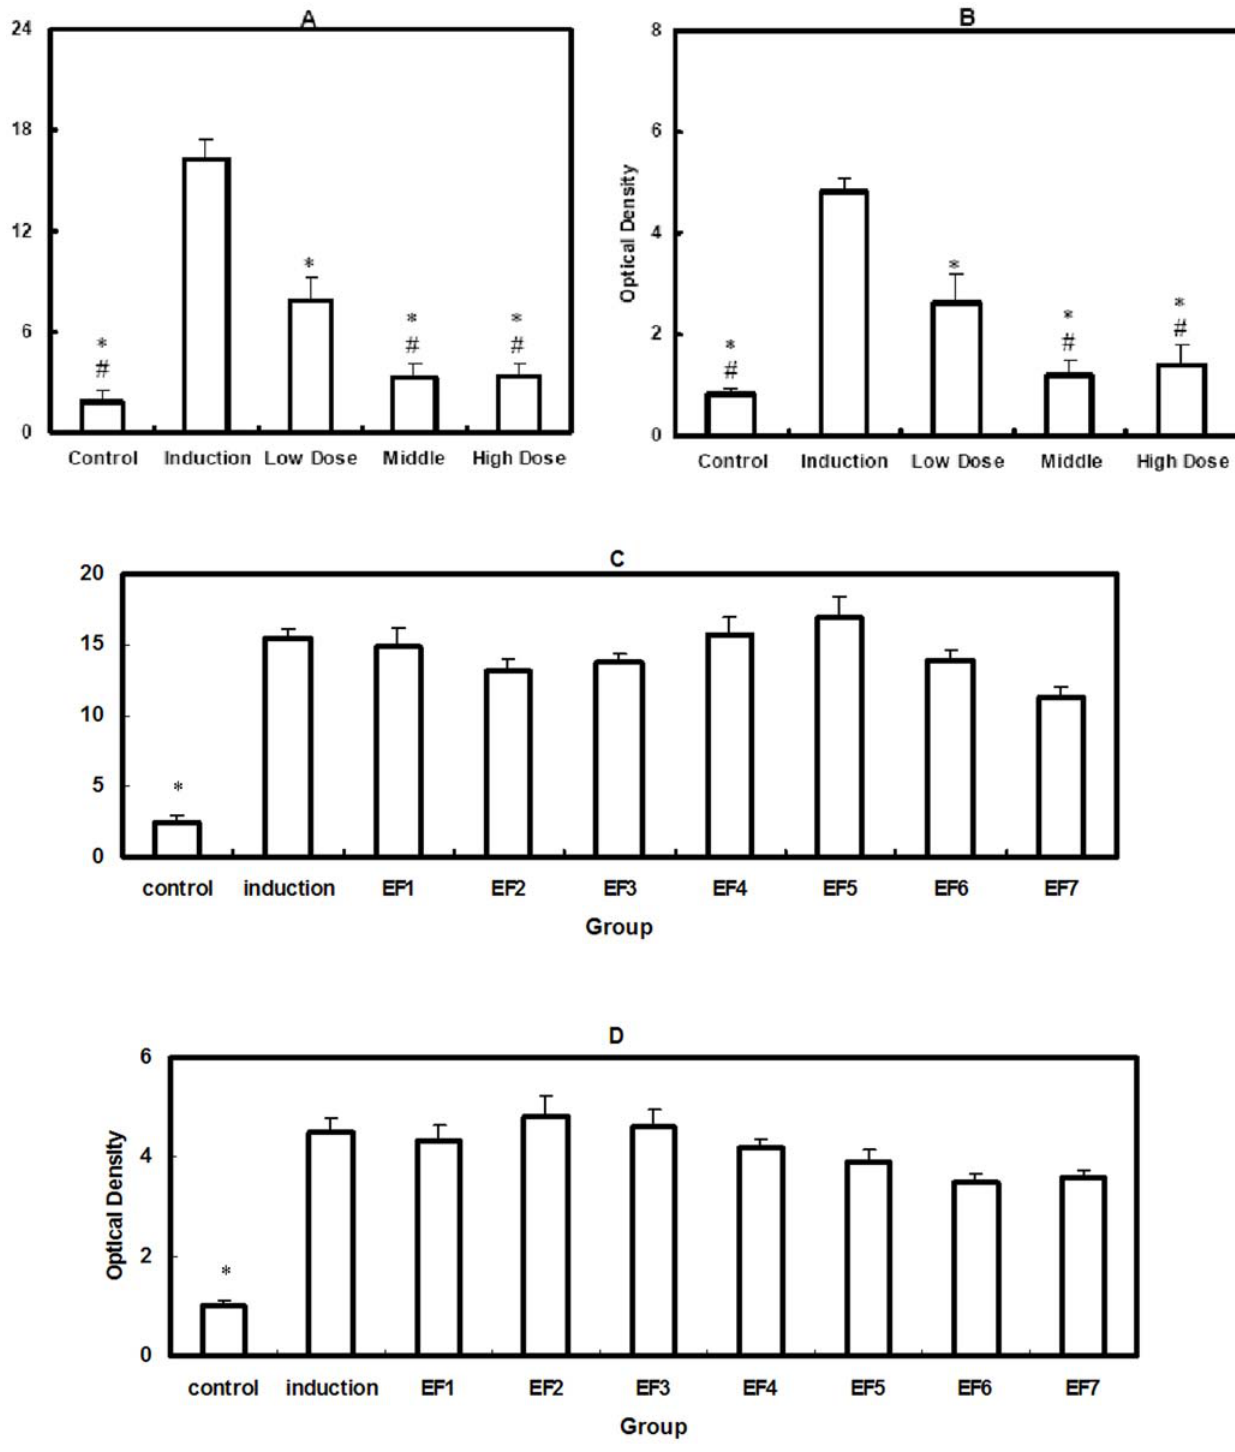
Figure 5. Supernate soluble TM in endotoxin induction group (A) and optical density in destained oil red O staining in steroid induction group (B) was significantly higher than the corresponding control group, respectively, whereas Icaritin dose- dependently lowered supernate soluble TM (A) and optical density in destained oil red O staining (B) when compared to the corresponding induction group, respectively. However, no differences were found between the seven parent flavonoids in EF at the concentration of 10 2 14 M and corresponding induction group both in supernate soluble TM (C) and optical density in destained oil red O staining (D) . Note: * P , 0.05 for comparison with the induction group. # P , 0.05 for comparison with the low dose group.